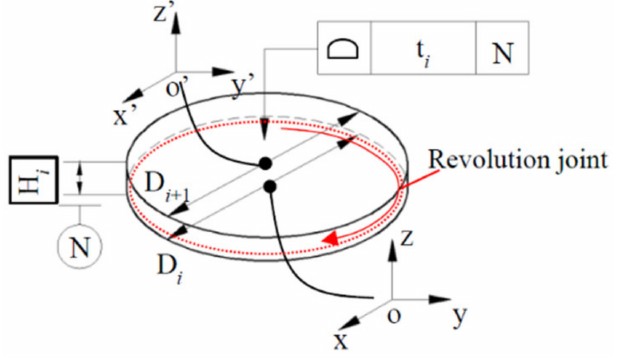
Figure 7. Rotors with